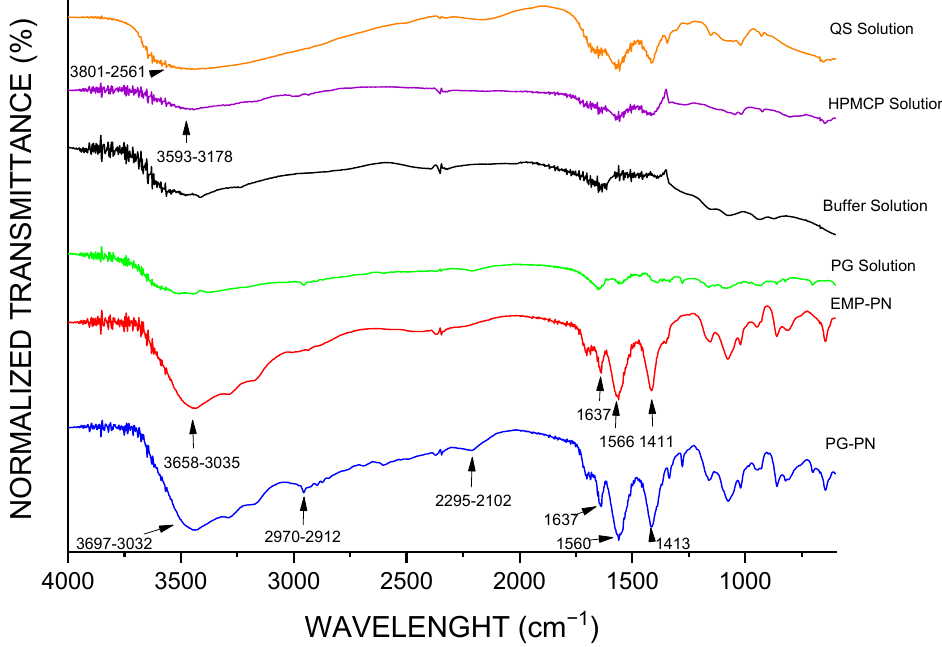
Figure 6. FT-IR by KBr dropping of nanocomplexes and formulation components.